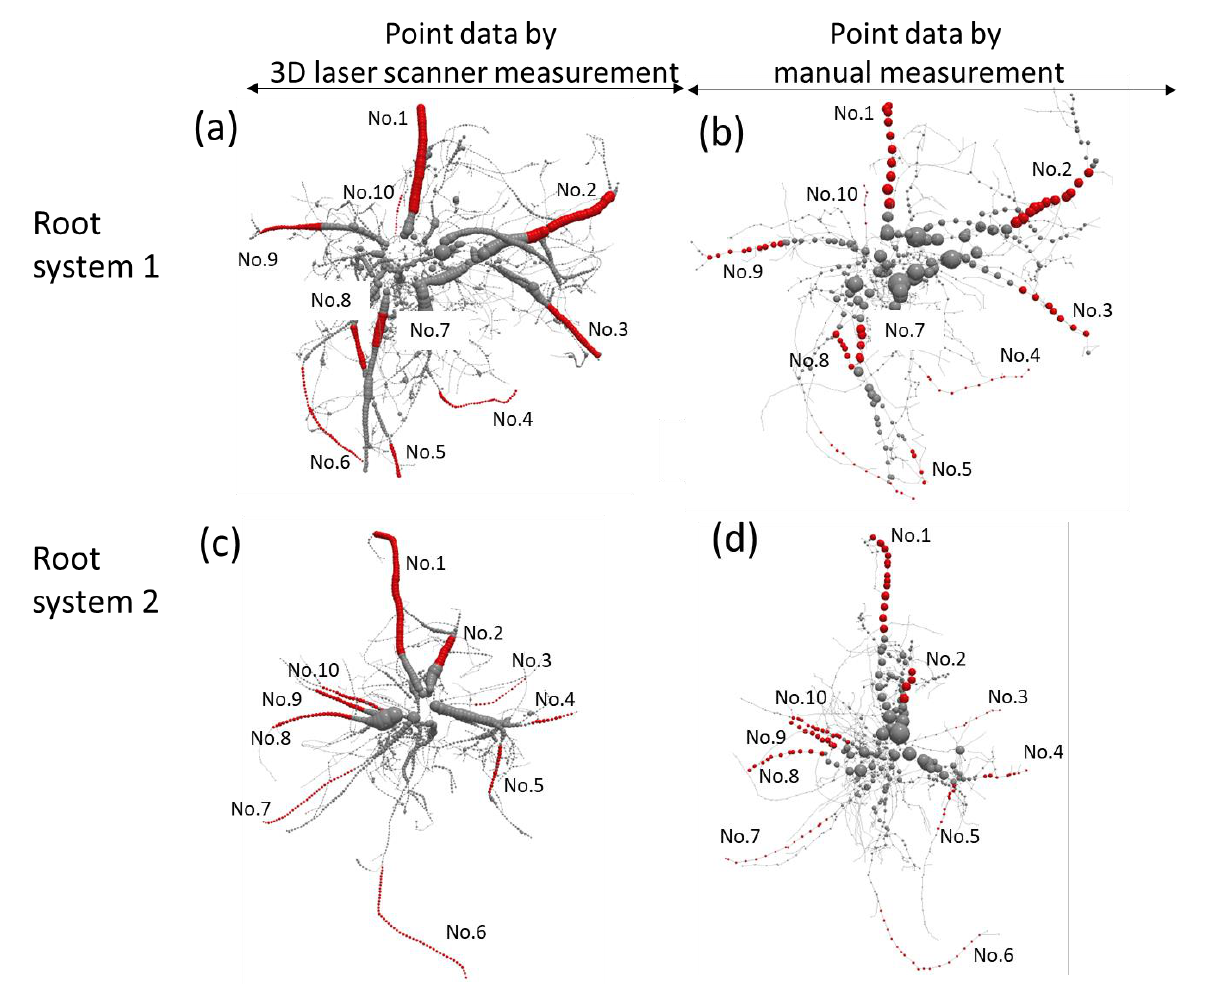
Figure 6. Ten main root segments in each root system selected to compare tapering between ( a , b ) in Root system 1; and ( c , d ) in Root system 2 measured by ( a , c ) 3D scanner and ( b , d ) hand.